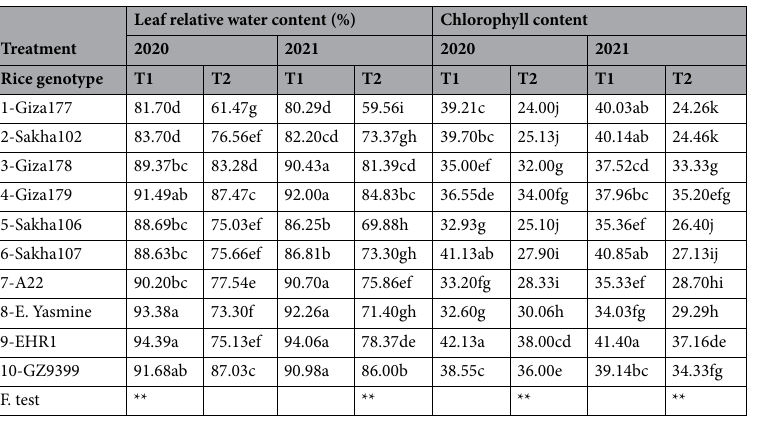
Table 8. Leaf relative water content and chlorophyll content affected by the interactions. T1 = Transplanting, T2 = Aerobic, **Significant at 0.01 level. Means followed by a common letter at the same column are not significantly different according to Duncan ’ s multiple range at 0.05 levels.